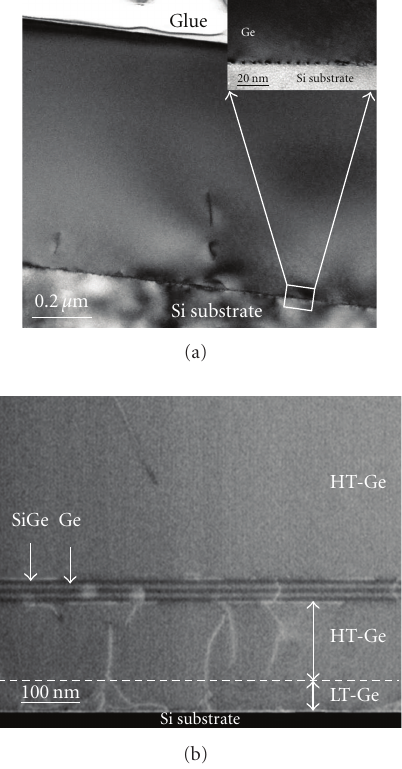
Figure 1: Transmission electron microscope cross-sections of Ge- on-Si layers for (a) typical and (b) modified two-step